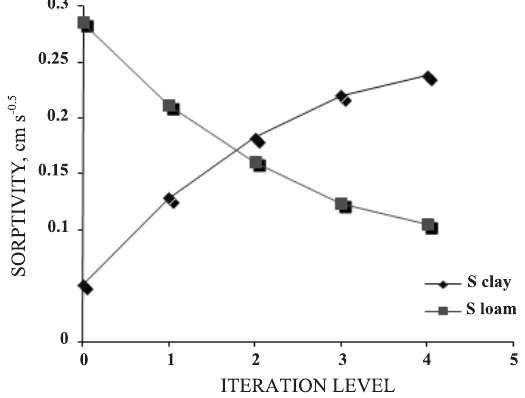
Figure 6. Sorptivity parameter estimated with time exponent fixed at 0.5 at each iteration level for clay and loam